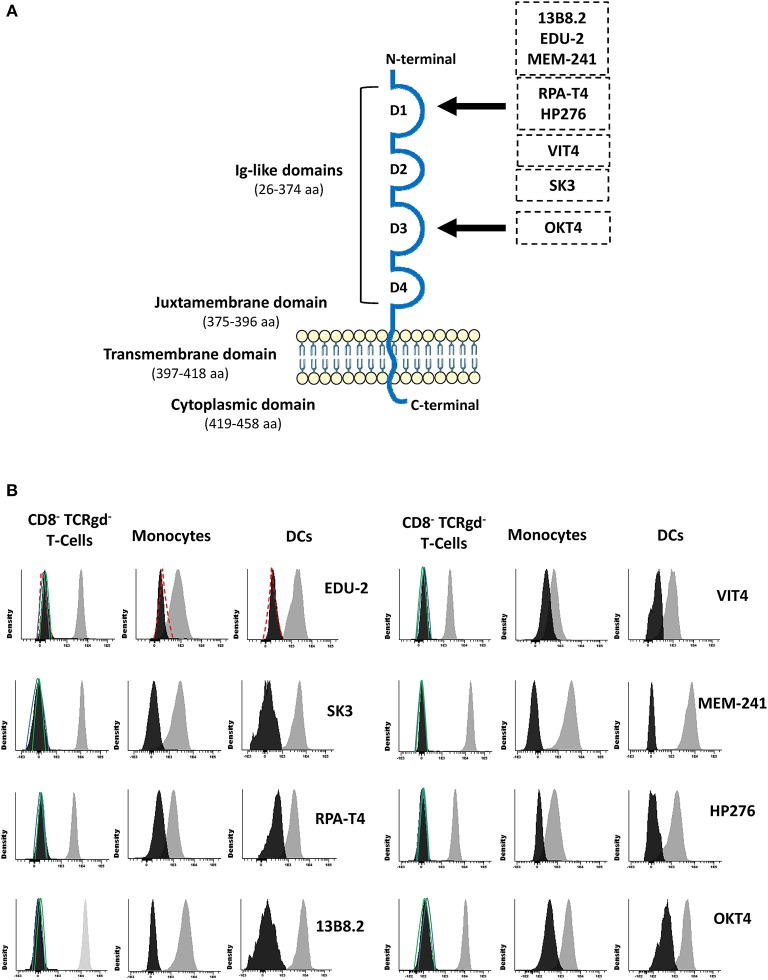
Schematic representation of the CD4 protein molecule (A) and CD4 surface membrane expression in the patient's (vs. healthy donor) blood CD8− TCRγδ− T-cells, monocytes, and dendritic cells (B). Panel (A) shows a schematic representation of the CD4 protein molecule including the localization of epitopes identified by the distinct antibody clones used in this study (29–31). Amino acid positions that conform each domain are indicated between brackets. Black arrows depict the domain that contains those epitopes that the antibody clones are directed to. Panel (B) shows CD4 surface membrane expression levels for CD8− TCRγδ− T-cells, monocytes, and dendritic cells for the different anti-CD4 antibody clones tested in the patient (black histogram) compared to a representative healthy donor (gray histogram) and an isotype control (red dash line), and the staining for a negative population (CD8+ T-cells) in the patient (green line) and the healthy control (blue line). DCs, dendritic cells.